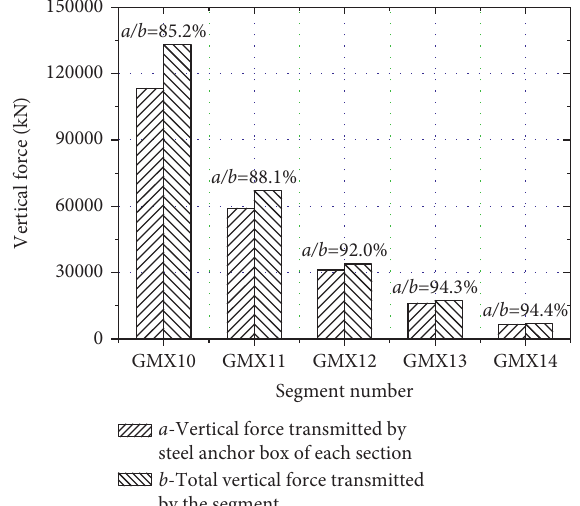
Figure 11: Vertical force transferred by the tower wall.